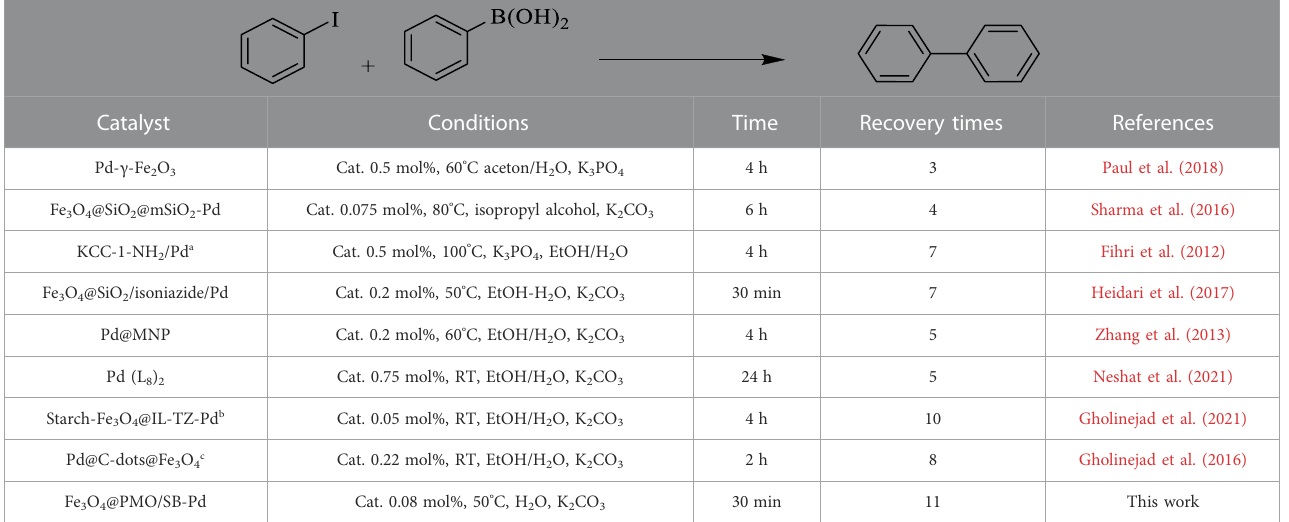
TABLE 3 Comparison the ef fi ciency and recoverability of Fe 3 O 4 @PMO/SB-Pd with previous catalysts.